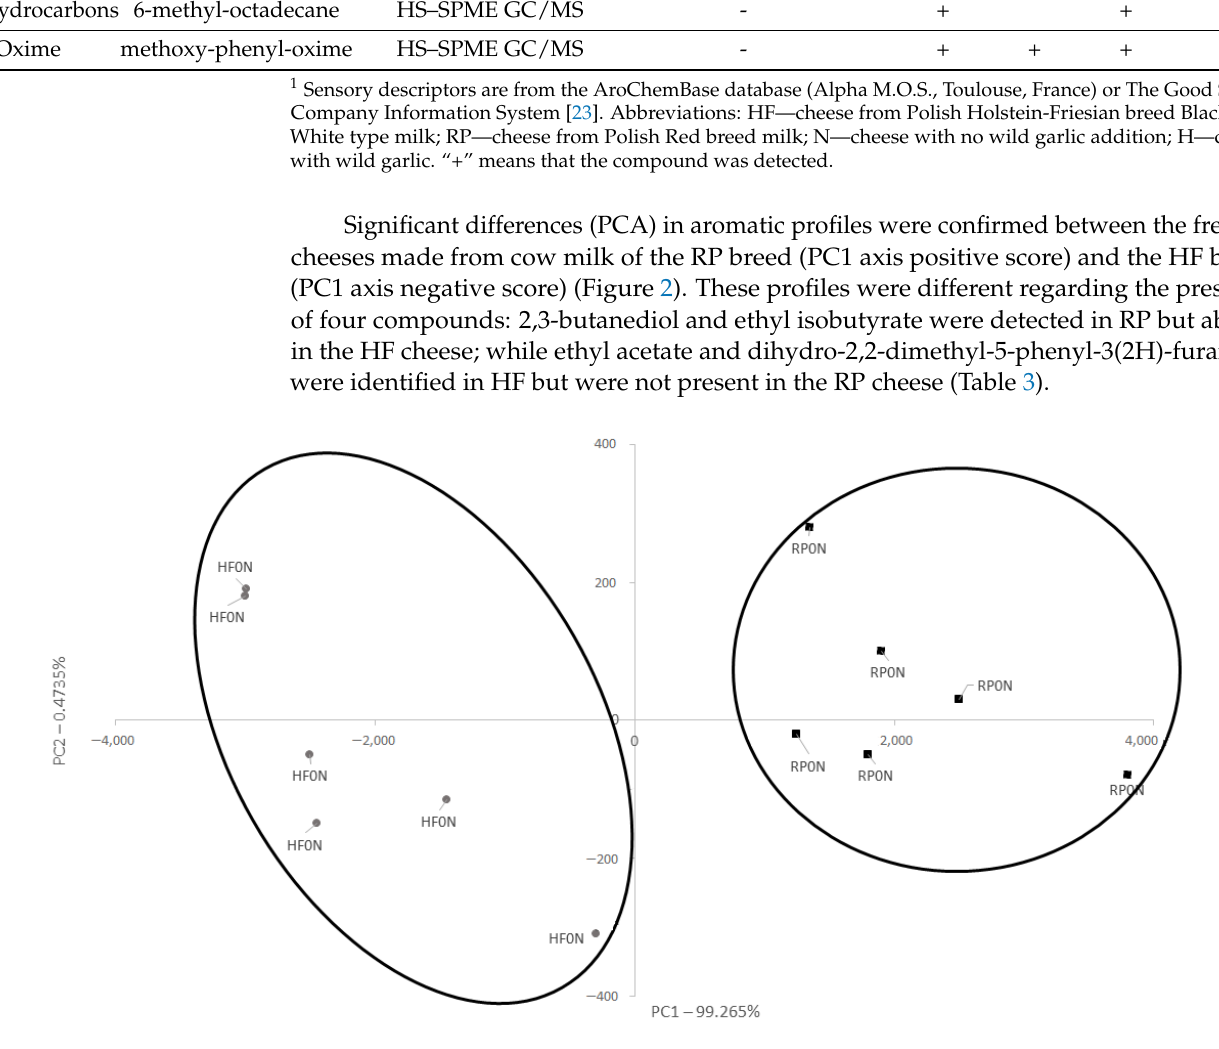
Figure 2. Aromatic profile PCA of fresh natural cheeses from Polish Holstein-Friesian breed Black-and-White type milk and from Polish Red breed milk. Abbreviations: HF — cheese from Polish Holstein-Friesian breed Black-and-White type milk (gray); RP — cheese from Polish Red breed milk (black); 0 — fresh samples; N — cheeses with no wild garlic addition.